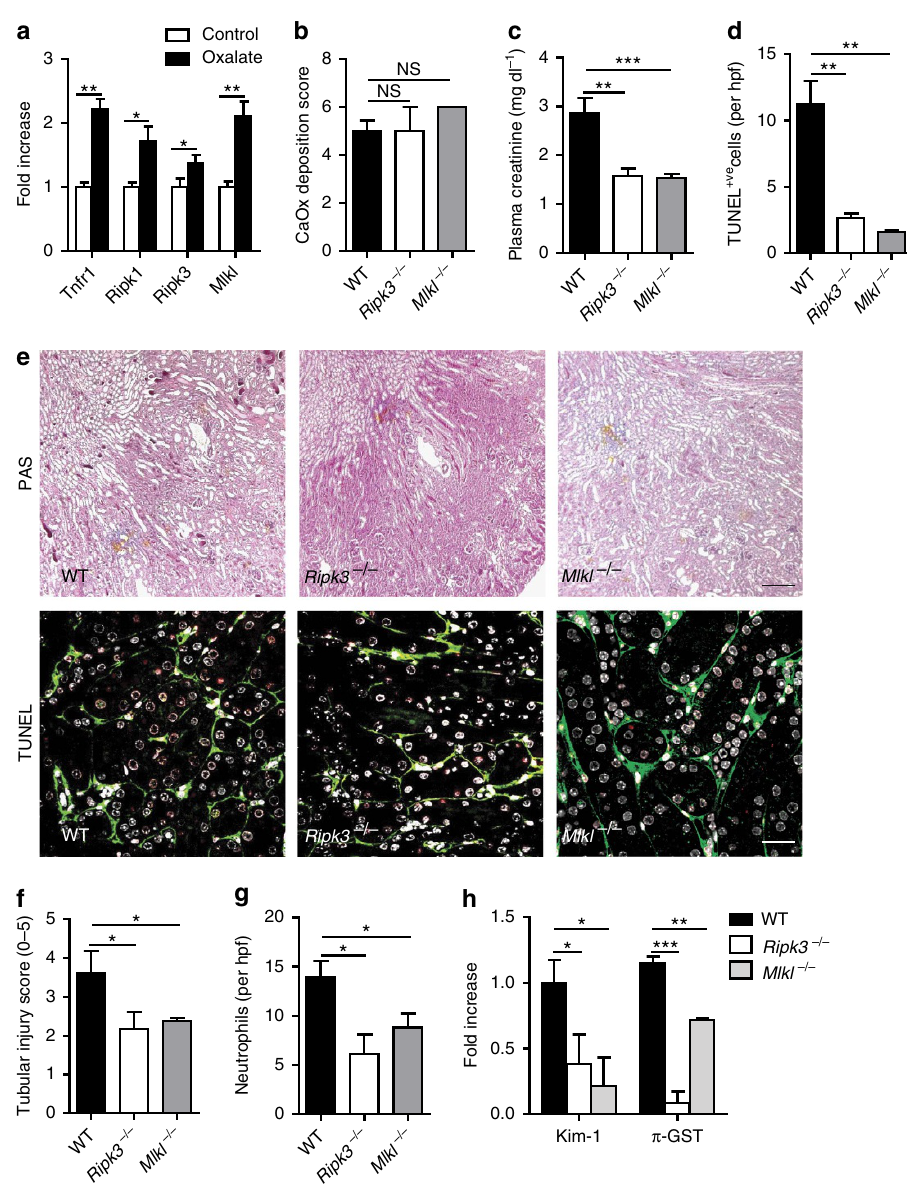
Figure 5 | Oxalate nephropathy in C57BL/6 mice requires RIPK3 and MLKL. ( a ) Oxalate injection to C57BL/6 mice ( n ¼ 5) induced intrarenal mRNA expression of TNFR1, RIPK1, RIPK3 and MLKL as determined by RT–PCR from total kidney isolates. ( b ) Oxalate feeding to wild-type mice as well as to Ripk3 - and Mlkl -deficient mice of the same genetic background resulted in identical amounts of CaOx crystal deposition after 24h as quantified by morphometry of Pizzolato-stained kidney sections. ( c , d ) Oxalate nephropathy in wild-type mice was associated with increased plasma creatinine ( c ) and TUNEL positive cells ( d ), which was both attenuated in the gene deficient mouse strains. ( e ) PAS staining illustrated tubular necrosis at the corticomedullary junction